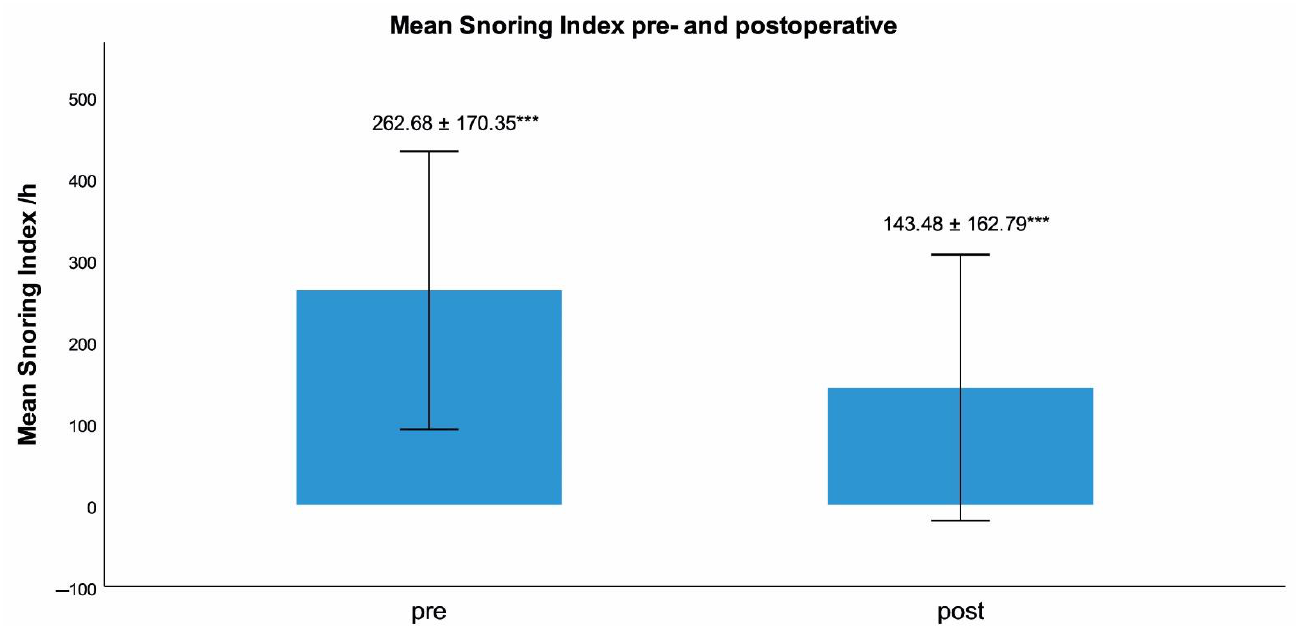
Figure 2. Comparison of snoring index pre-and postoperative: 262.68 ± 170.35, 143.48 ± 162.79, p < 0.001 *** = statistically significant difference with p < 0.001; error bar with ±